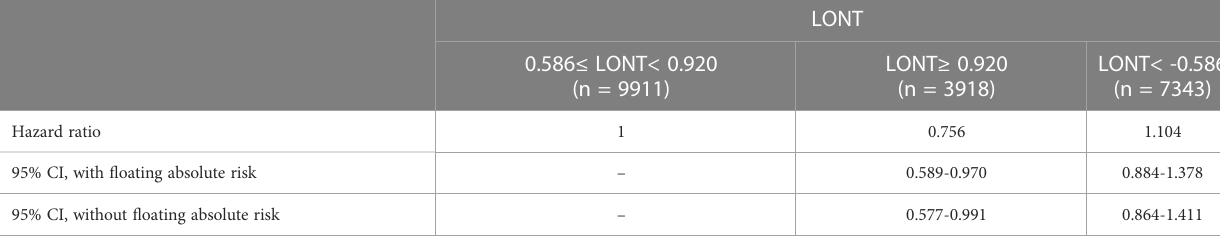
TABLE 2 Adjusted Hazard Ratios for OS to patients with different LONT by fl oating absolute risk